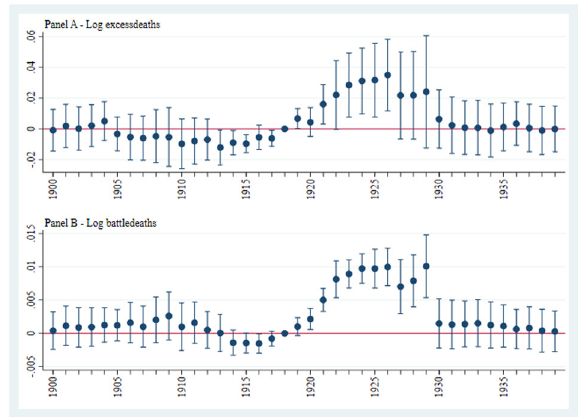
Fig. 4 Estimated coef fi cients from a fl exible model using ln( excessdeaths ) or ln( battledeaths ) as explanatory variable. Panel ( A ) shows the point estimates from a fl exible difference-in-differences model with ln ( excessdeaths ) on tariff . Panel ( B ) shows the point estimates from a fl exible difference-in-differences model with ln( battledeaths ) on tariff . The base year is 1918 and the error bars show p < 0.1 based on robust standard errors, clustered at the country